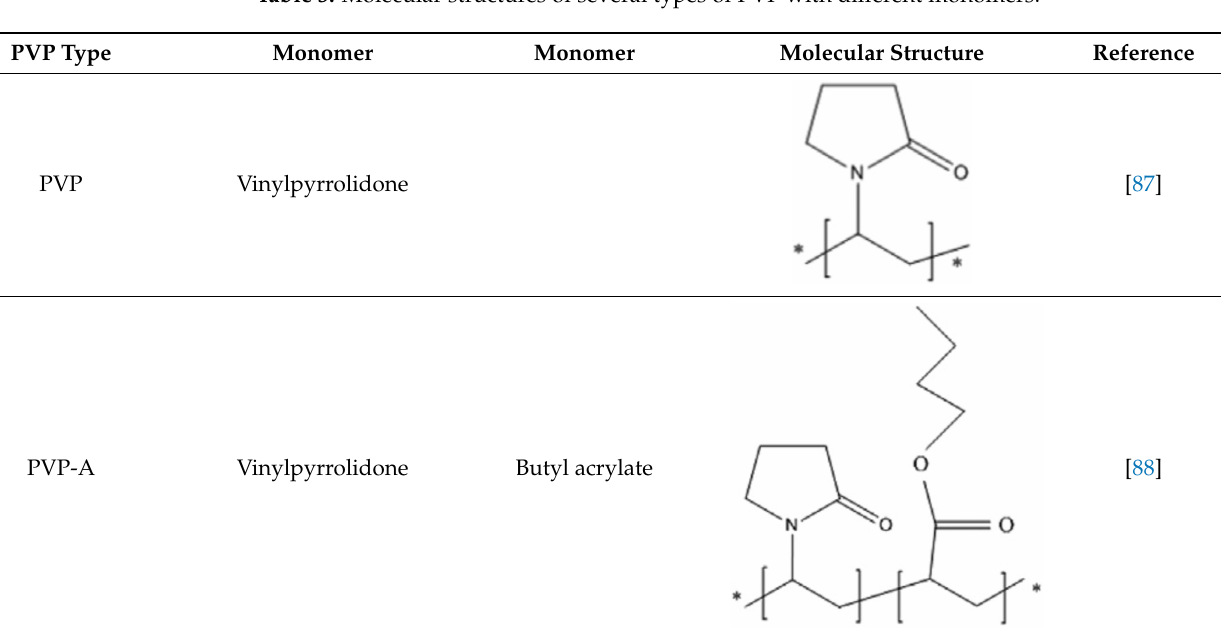
Figure 9. Three-dimensional structure of poly(vinyl pyrrolidone) (PVP). Table 3. Molecular structures of several types of PVP with different